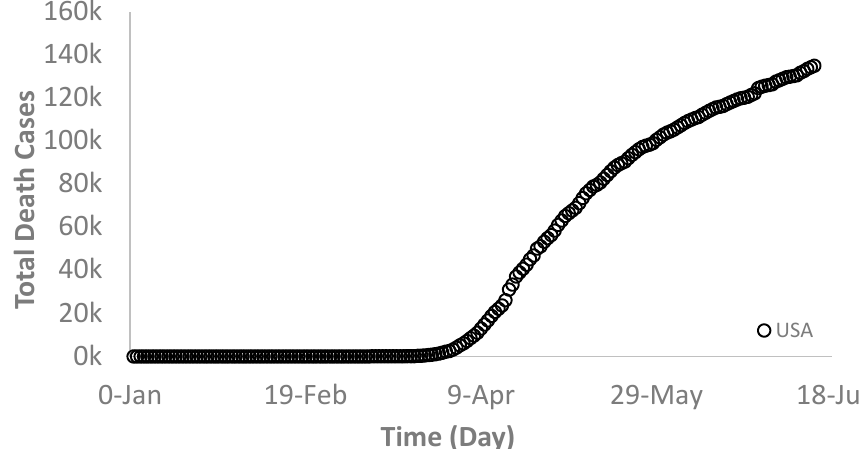
Figure 6. Total deaths due to the novel COVID-19 infections in the USA.